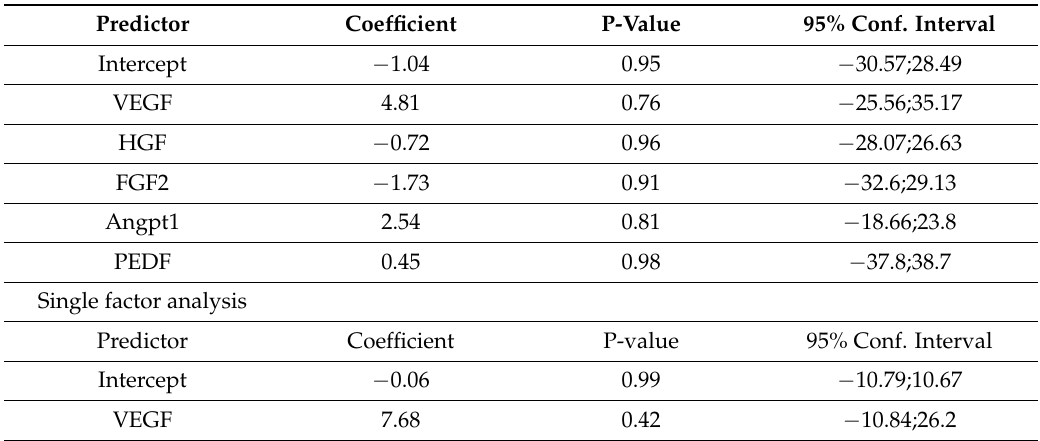
Table 5. Prediction model for NutriStem MSC-CM sample potency to stimulate human endothelial cell migration; n = 7 for train group, n = 5 for validation